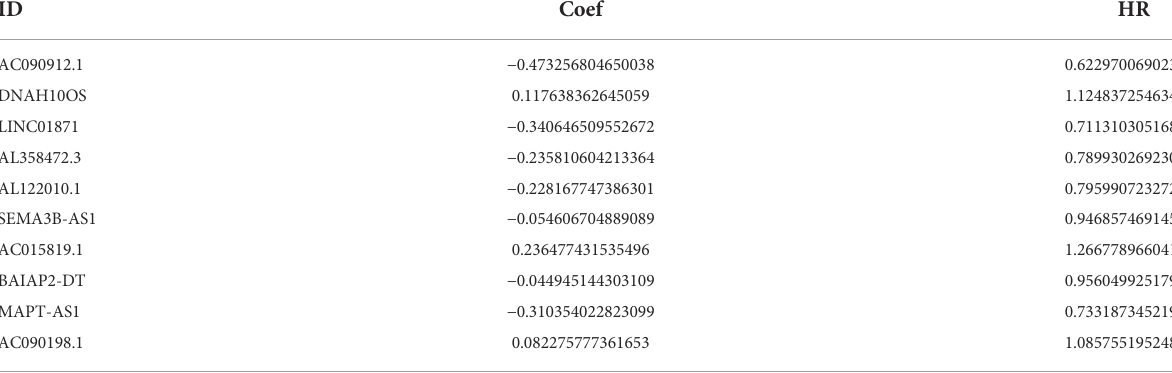
TABLE 2 Ten ARlncRNAs included in the ARlncRNA model and their regression coef fi cients and hazard